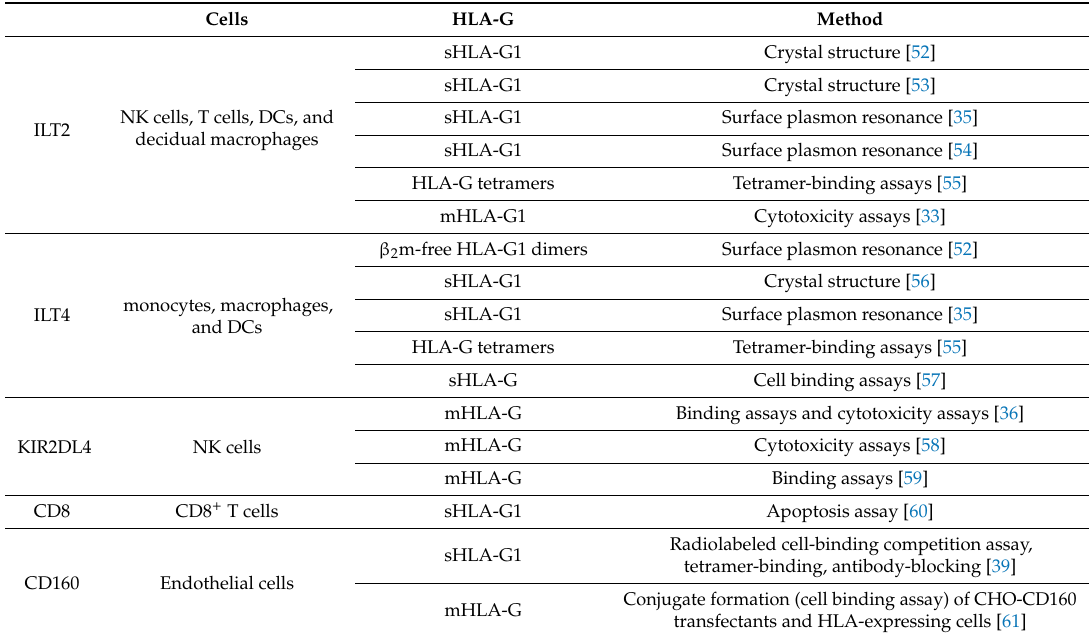
Table 1. Receptors for human leukocyte antigen